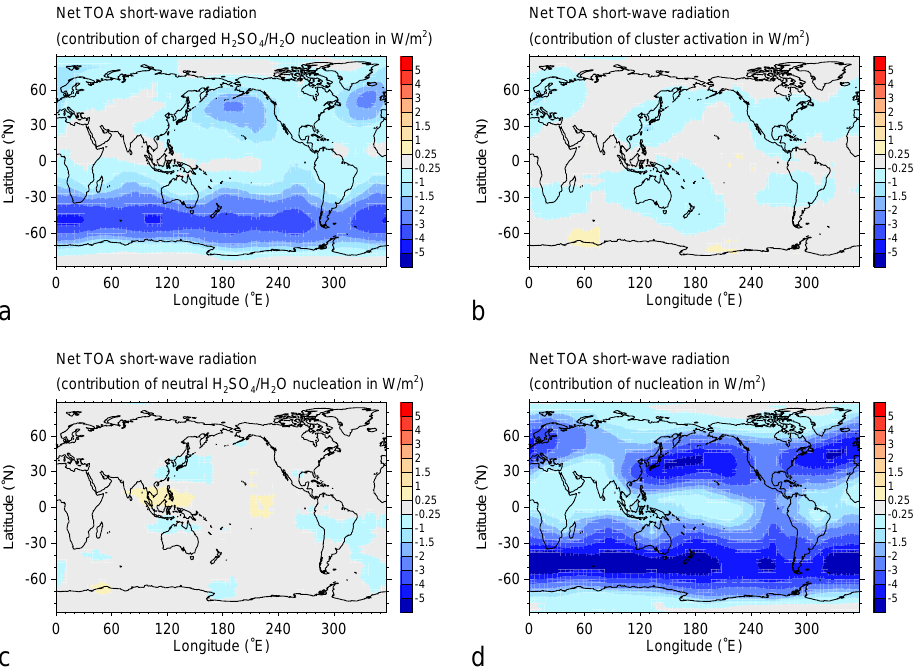
Fig. 11. Contribution of (a) charged H 2 SO 4 /H 2 O nucleation, (b) cluster activation, (c) neutral H 2 SO 4 /H 2 O nucleation, and (d) all nucleation in simulation S ref to the annual mean net top-of-the-atmosphere short-wave radiation. The data were smoothed using a box-shaped, area-weighted low-pass filter covering four latitude and eight longitude points.